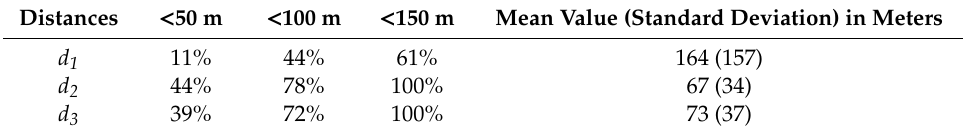
Table 2. Distances between AIS and SAR locations (Ship #12 and #18 are excluded since the wake-based azimuth o ff set estimation cannot be applied in these